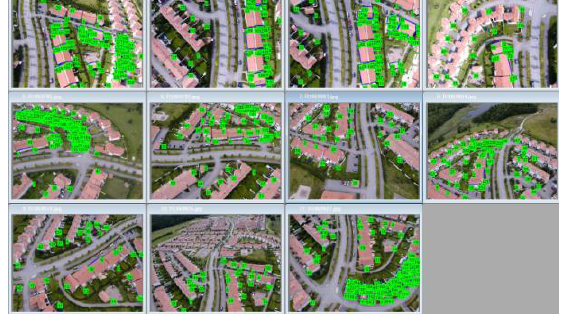
Figure 5. The result of pole extraction The poles as reference points for UAV image are more accurate than manual pick up points from point cloud. And also the algorithm for pole detection is fairly high efficient. The run time takes only few seconds in the testing data. Additionally, people usually use building corners as referencing points. As we know, the building corners from laser data might be not accurate enough due to object scanned line by line. The laser hits on the corners do not exactly get the right returns. It depends on the size of laser footprint and the position of laser hits on the building corners. For example, when a laser footprint partly hits the building corner and partly hits the other close objects or ground, the laser return would not be exactly on the corner. Maybe the corner point is missing. 2.2.2 UAV image block and georeferencing to MLS